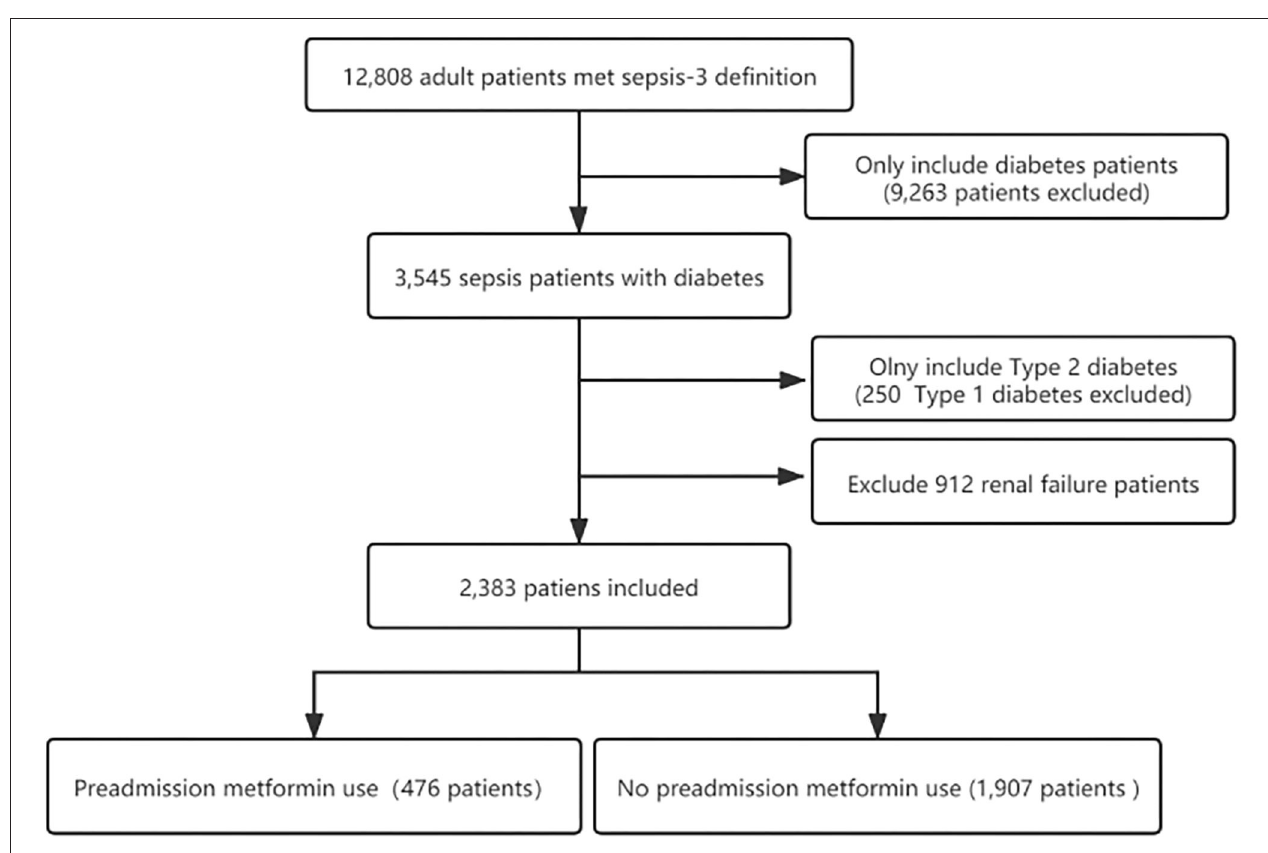
FIGURE 1 | The flow chart of the